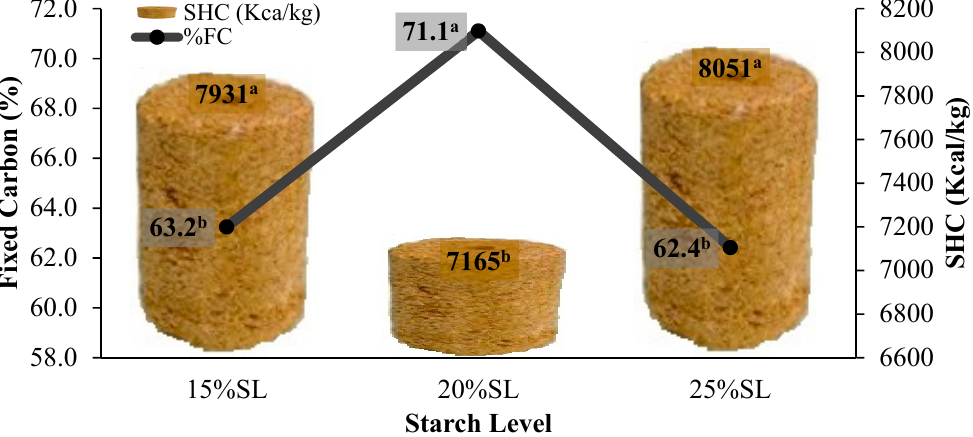
Figure 9 . Effect of starch levels on percentage specific heat of combustion (kcal/kg) and fixed carbon (%FC) of the briquette . Means in the same bar having the same superscript are not significantly different ( p ≥ 0.05).